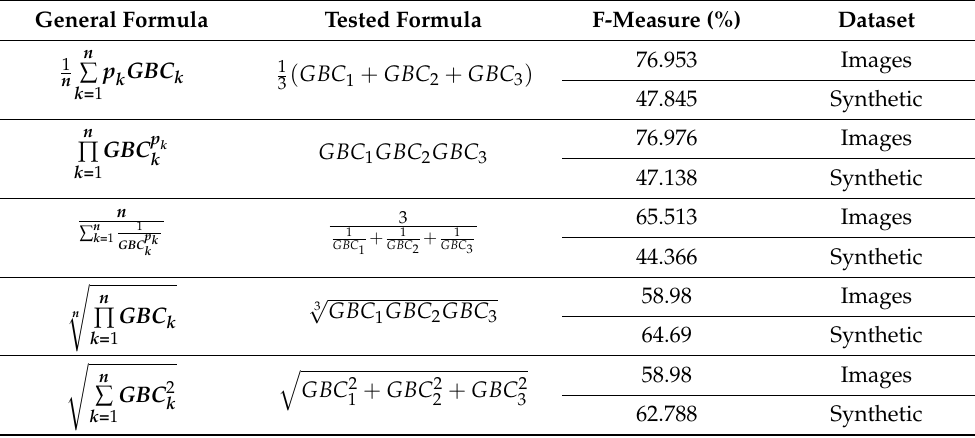
Table A1. Results for different formulas we experimented with. General